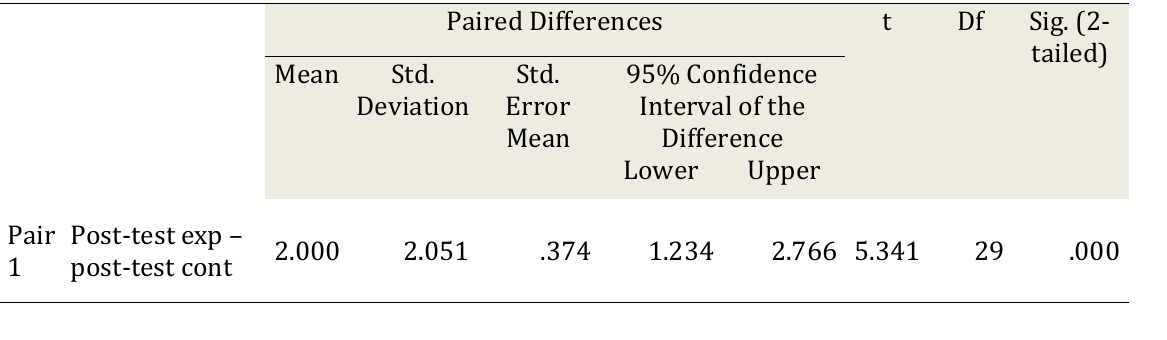
Table 4.29 The Probability Score of T-Test of Posttest in Experimental and Control